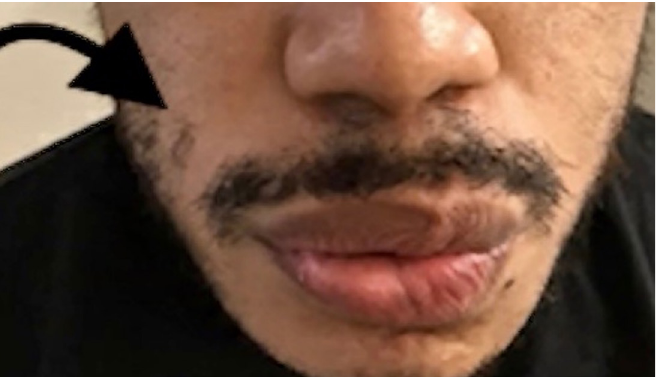
Image 1. Flattening of the right nasolabial fold with inability to contract right-side of orbicularis oris